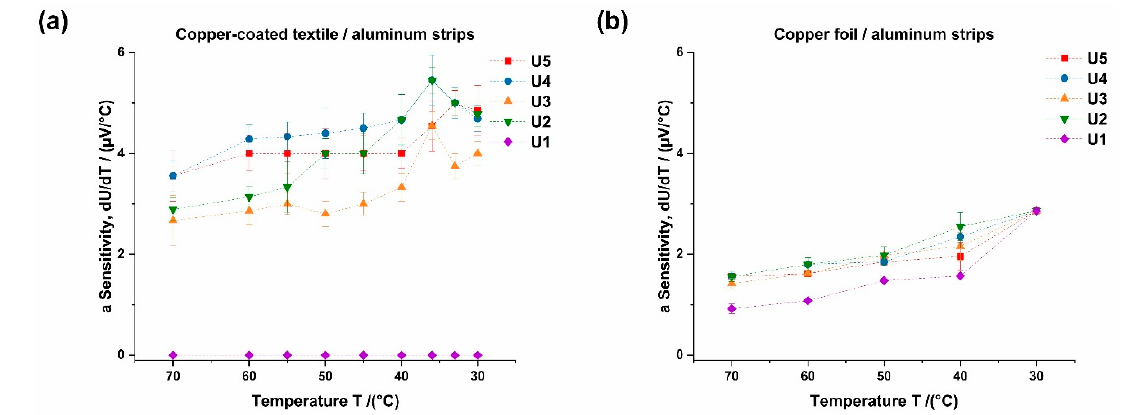
Figure 4. Temperature measurements performed using two different setups consisting of five measuring terminals and one reference terminal placed on ( a ) a copper-coated lyocell fabric, and ( b ) a copper foil. The dashed lines between the measured points were added to guide the eye.